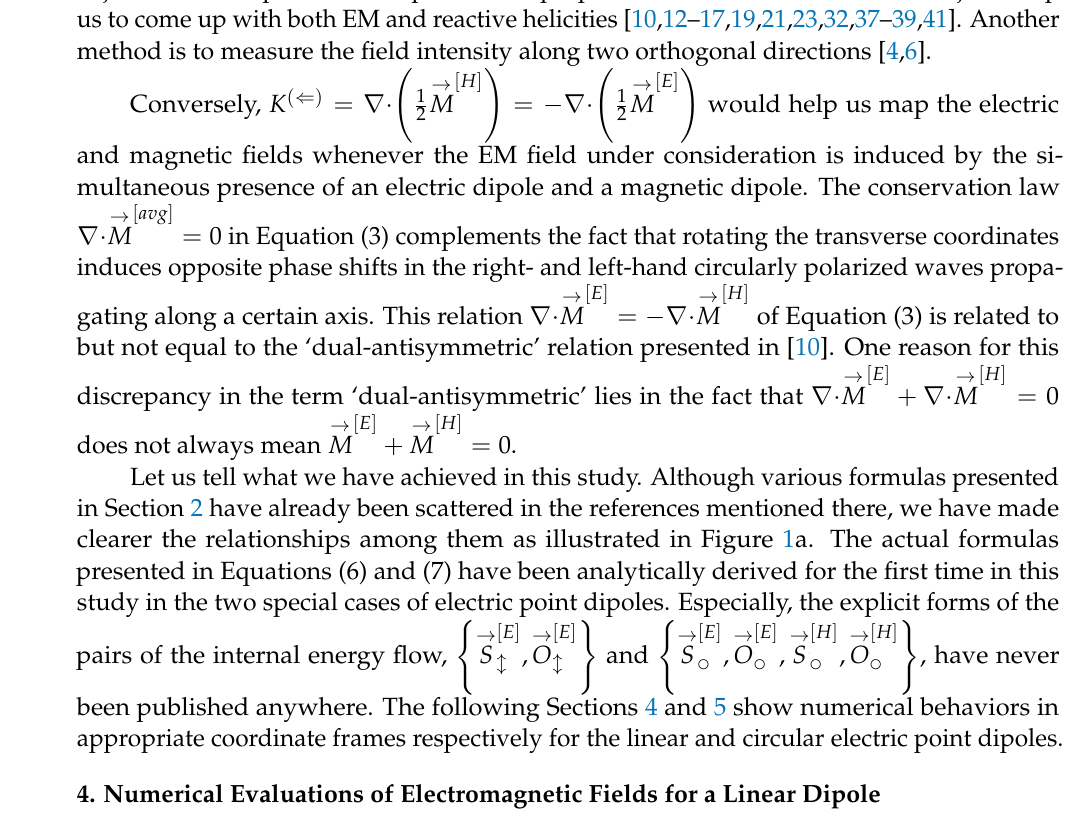
→ E (cid:108) andthefieldintensitiesforalineardipole